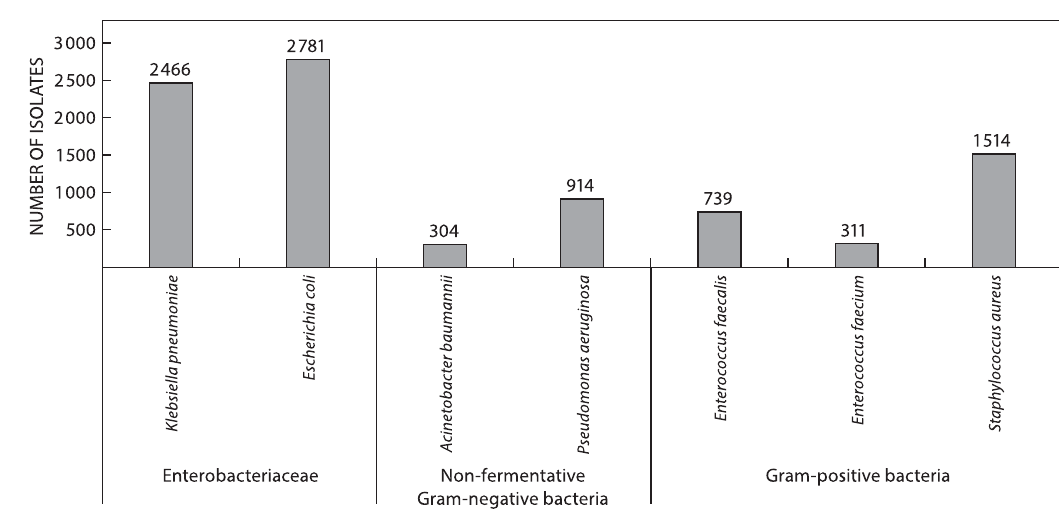
Figure 1: Number of ESKAPE isolates identi fi ed from blood cultures, January to December